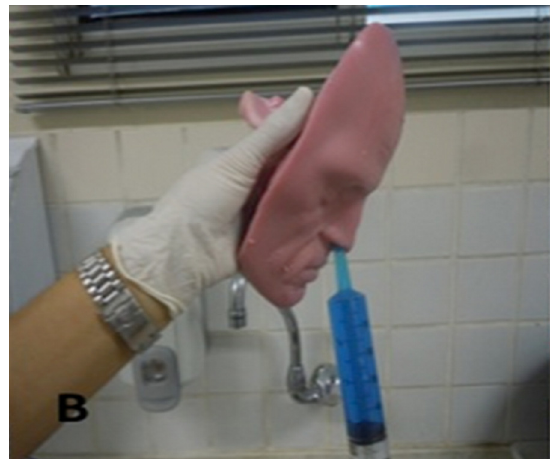
Topical therapy of irrigation with a syringe, per- formed in orthostatic position, simulating slight anterior head flexion (30 ◦